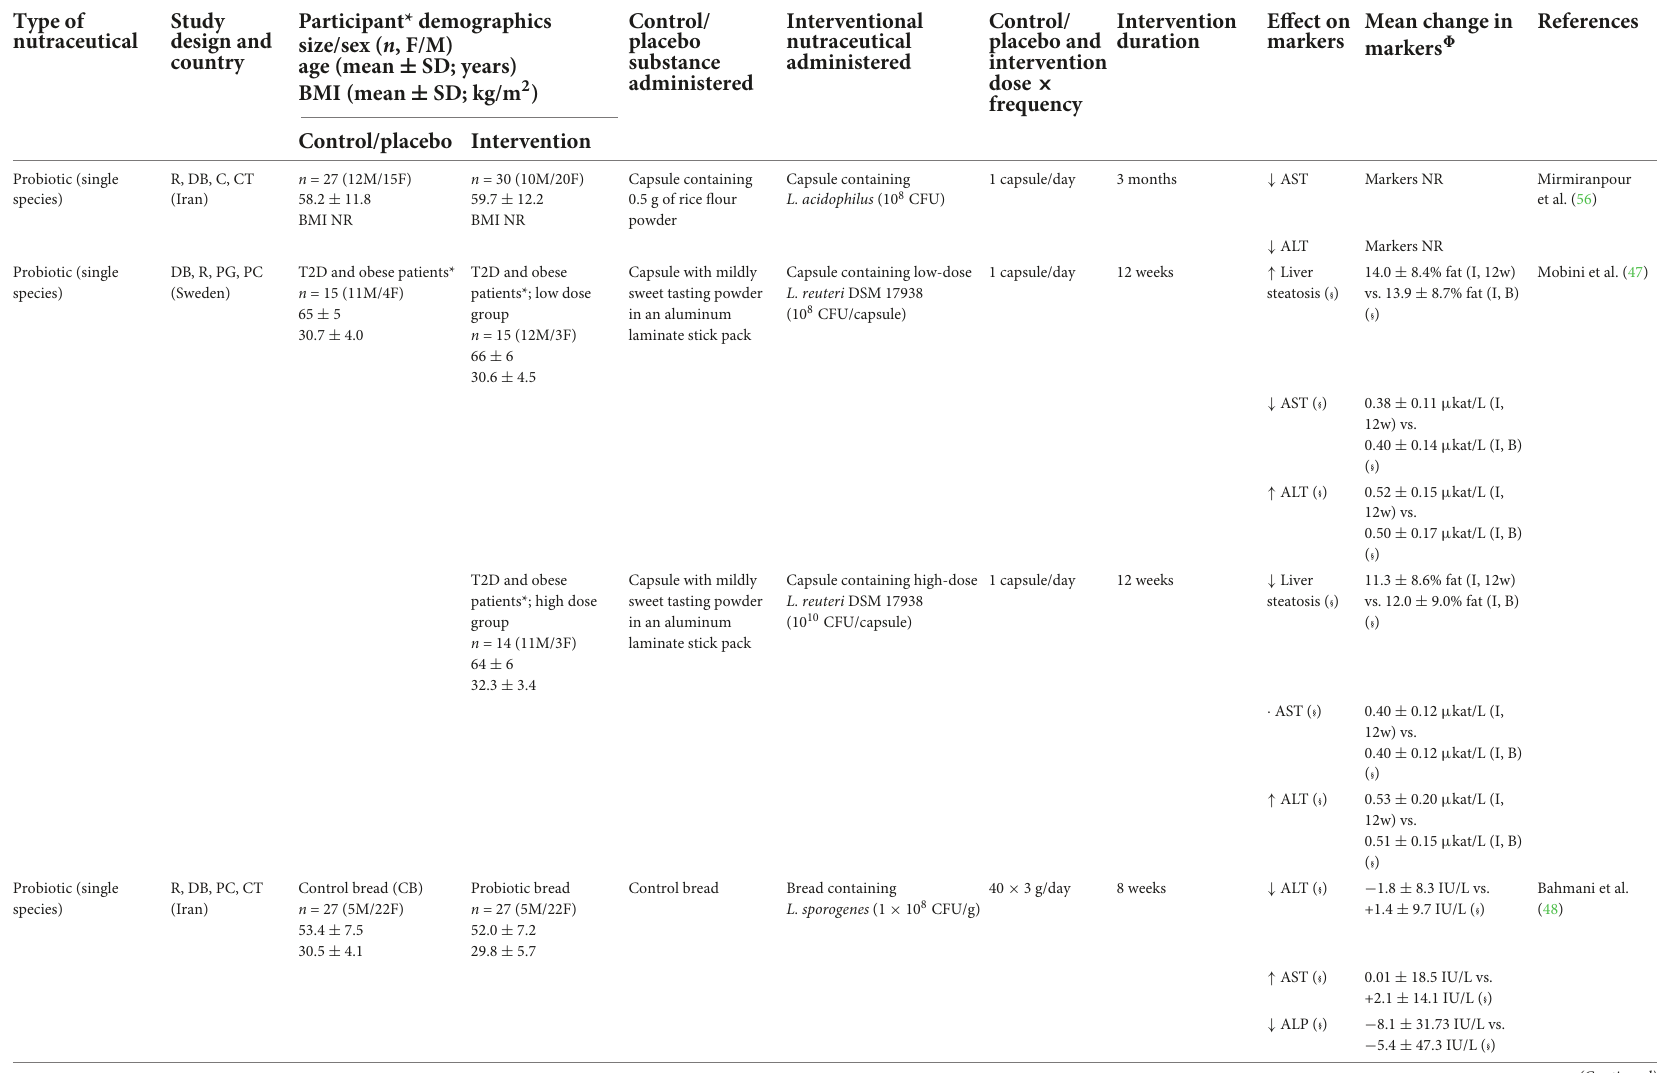
TABLE 1 Studies investigating changes in hepatic biomarkers following intervention with probiotics, prebiotics, and